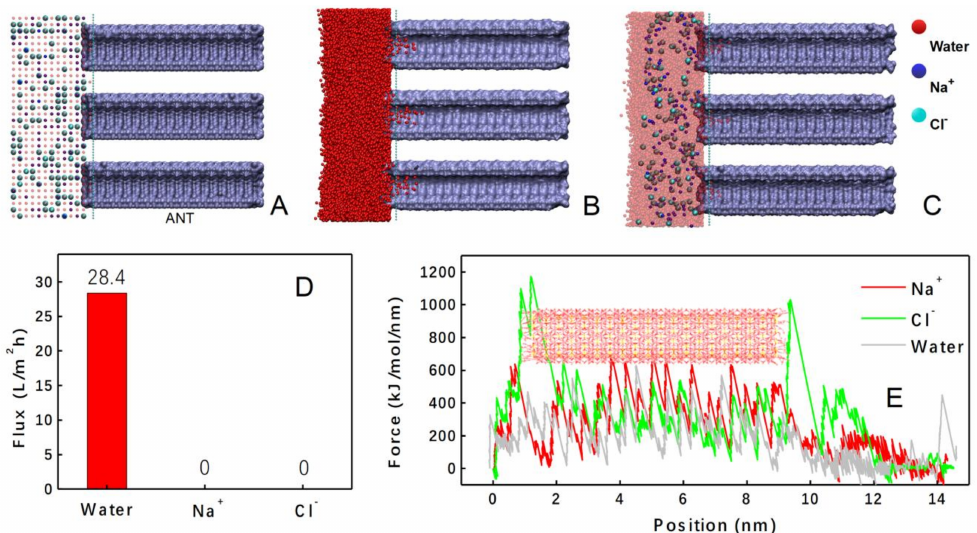
Figure 7. ( A ) The initial state of molecules transport into ANTs. ( B ) The state of water molecules in ANTs at 20 ns. ( C ) The state of sodium cations and chloride anions in ANTs at 20 ns. ( D ) Calculated flux of water molecules, sodium cations, and chloride anions. ( E ) The external force for water molecules, sodium cations, and chloride anions varied with the position in